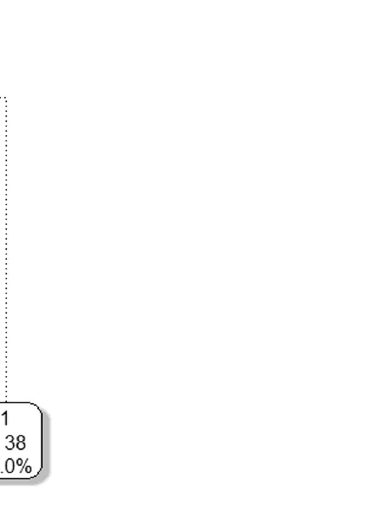
Figure 3. Optimal recursive partitioning tree fit to the simulated data in Fig.